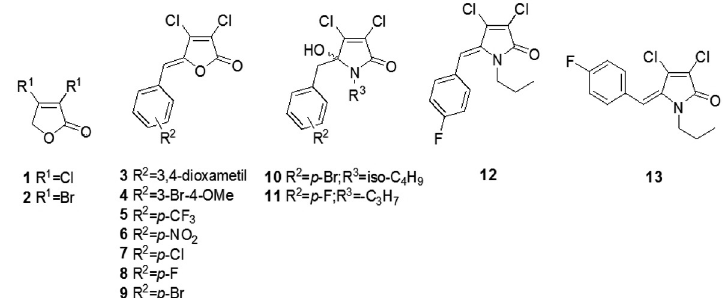
Figure 1- General structure for the test rubrolides-based γ-lactones